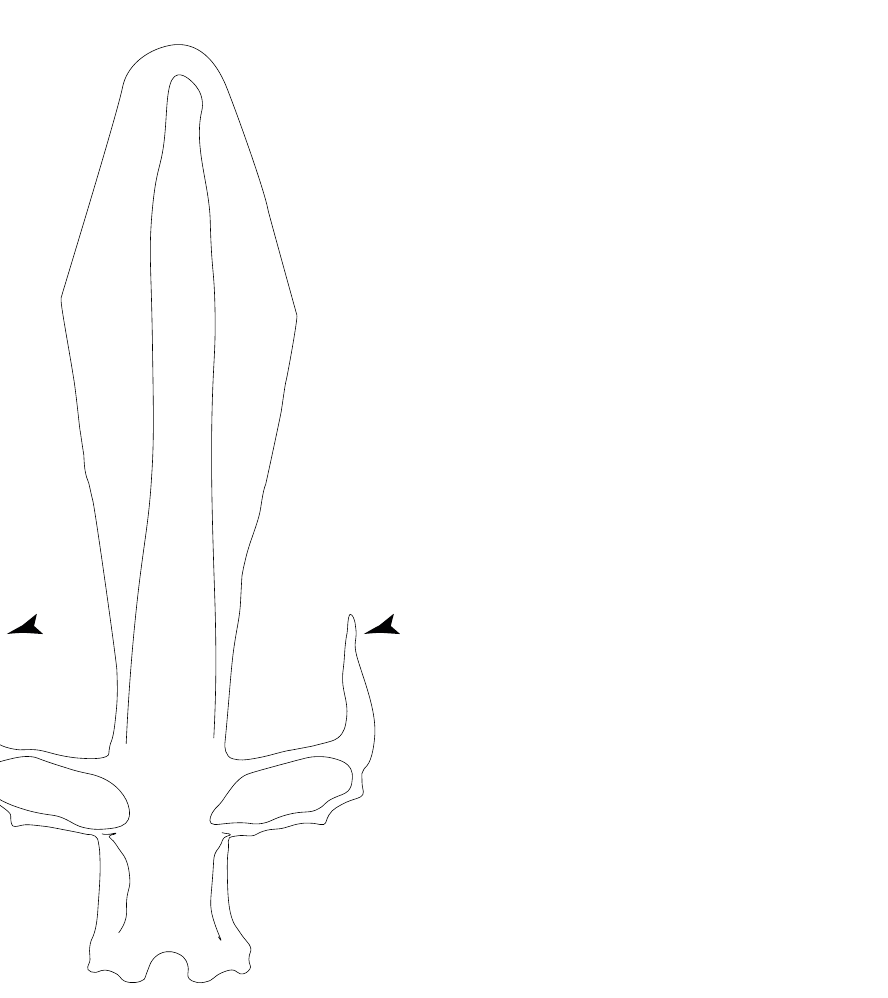
Figure 13. Interpretative drawings of ventral view of the neurocranium in ventral view of † “Rhinobatos” maronita (MNHN 1946.17.274): State (1). Arrowheads: horn-like process of nasal capsules. 110. Position of the articulation of the antorbital cartilage on nasal capsule: (0) Lateral, (1) anterolateral; (2) posterolateral. Modified from de Carvalho [67] (char. 2).